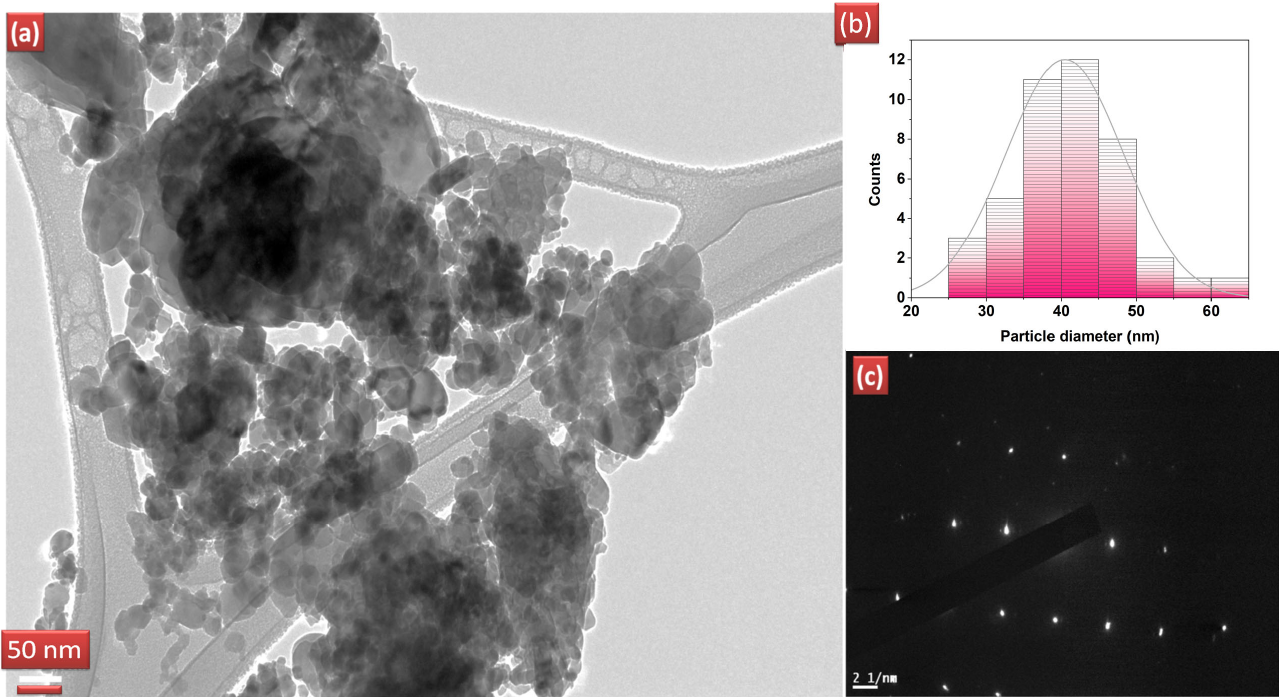
Figure 5. ( a ) TEM image for Dy doped ZnO nanoparticles, ( b ) particle size distribution, ( c ) corre ‐ sponding SAED pattern.